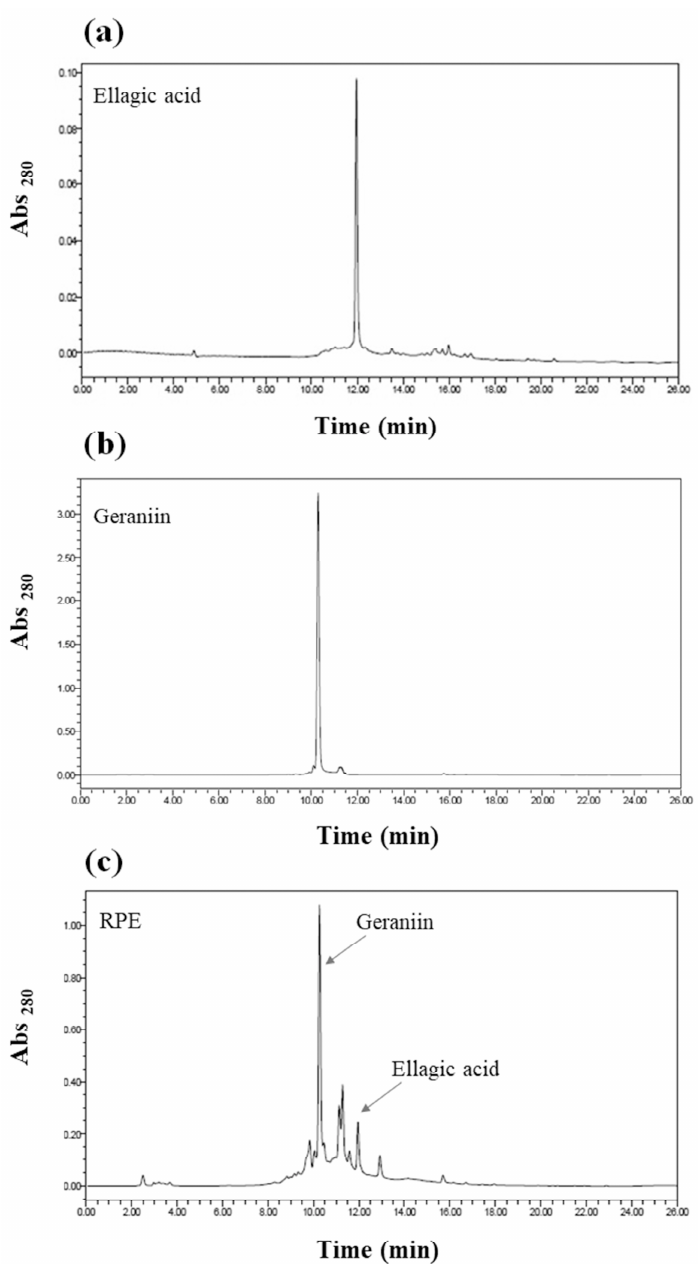
Figure 1. HPLC results of rambutan peel extract (RPE): ( a ) ellagic acid; ( b ) geraniin; ( c ) RPE.